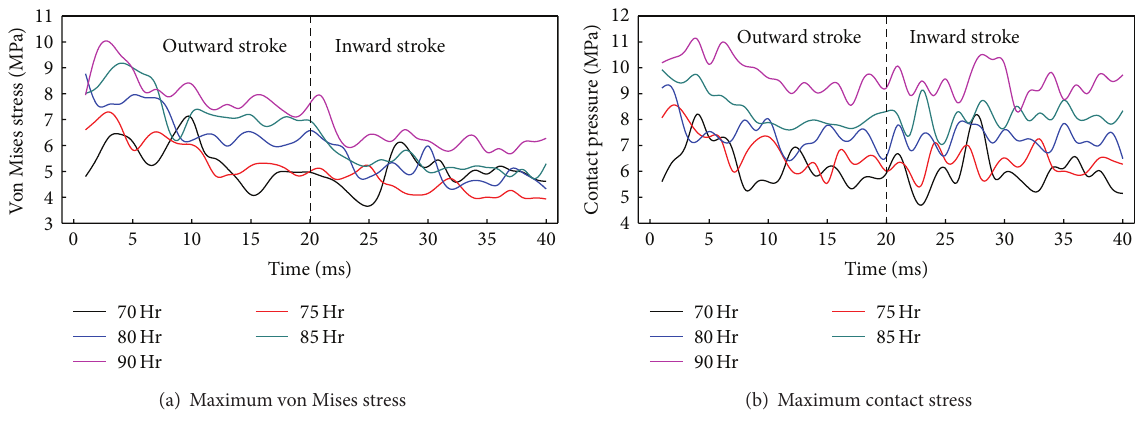
Figure 18: Stress of the biomimetic sealing ring under different material